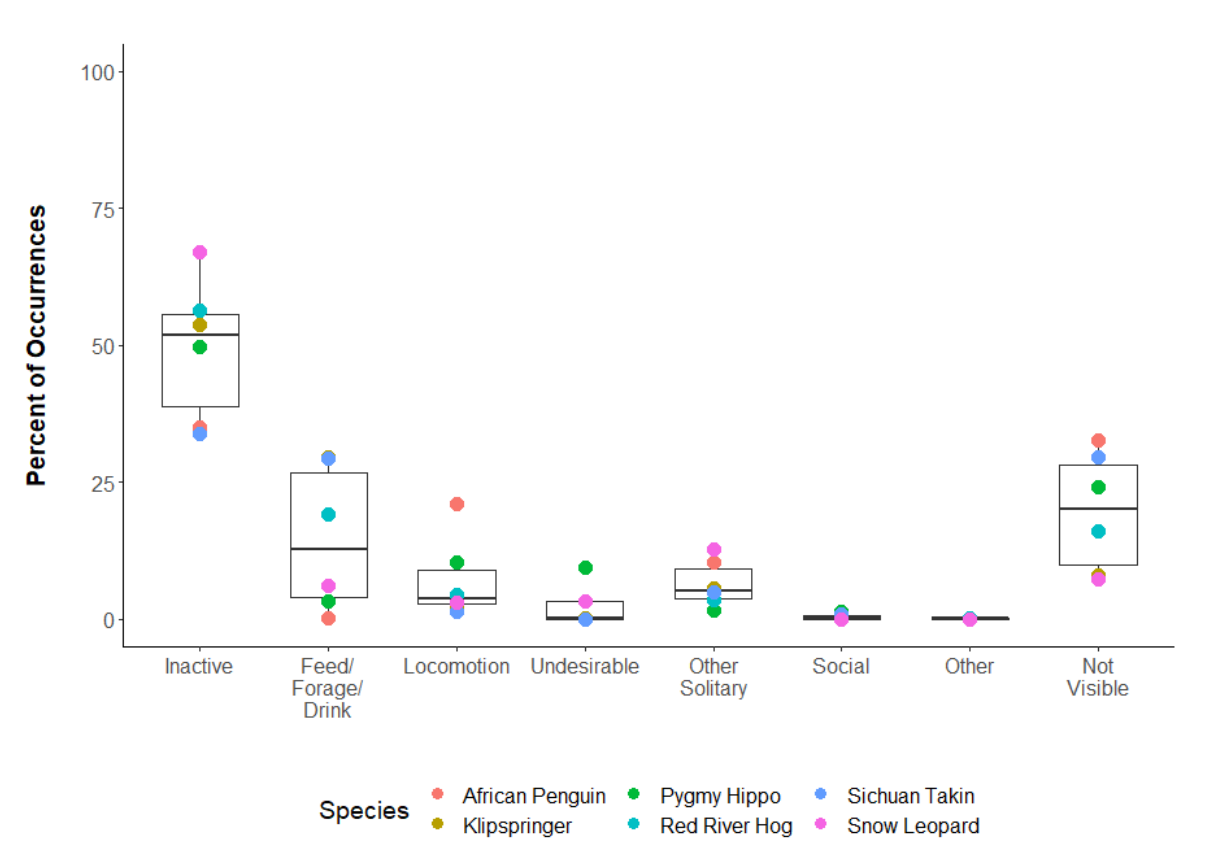
Figure 4. The overall percent of occurrences of behavior categories during inter-observer reliability tests for six study species monitored as part of a zoo-wide behavior monitoring program. Points representing species values are superimposed over boxplots depicting the median (line), inter-quartile range (box), and min and max values (whiskers) across species. Table 3. The percent of occurrences of ethogram behavior categories for the six study species recorded during inter-observer reliability tests of six study species monitored as part of a zoo-wide behavior monitoring program. Other Not Species Inactive Feed/Forage/Drink Locomotion Undesirable Social Other Solitary Visible African 35.1 Penguin Pygmy Hippo